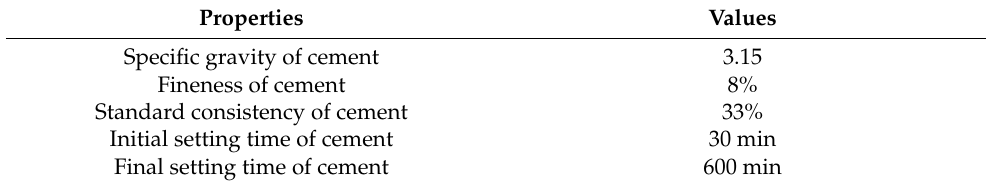
Table 1. Properties of cement.